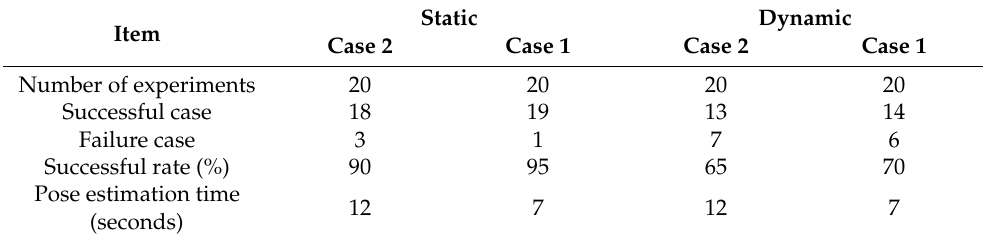
Table 1. Results of dynamic workpiece feeding compared with static workpiece